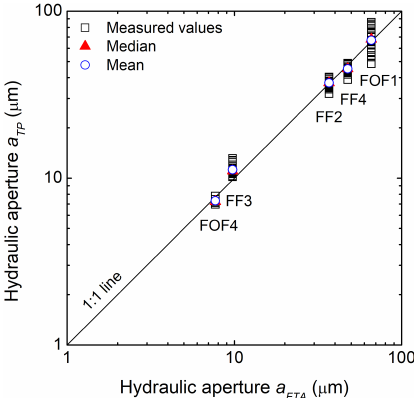
Figure 10. Cross-plot of the hydraulic apertures a TP determined with the transient-airflow permeameter (TP) and the hydraulic aper- tures a FTA measured with the flow-through apparatus